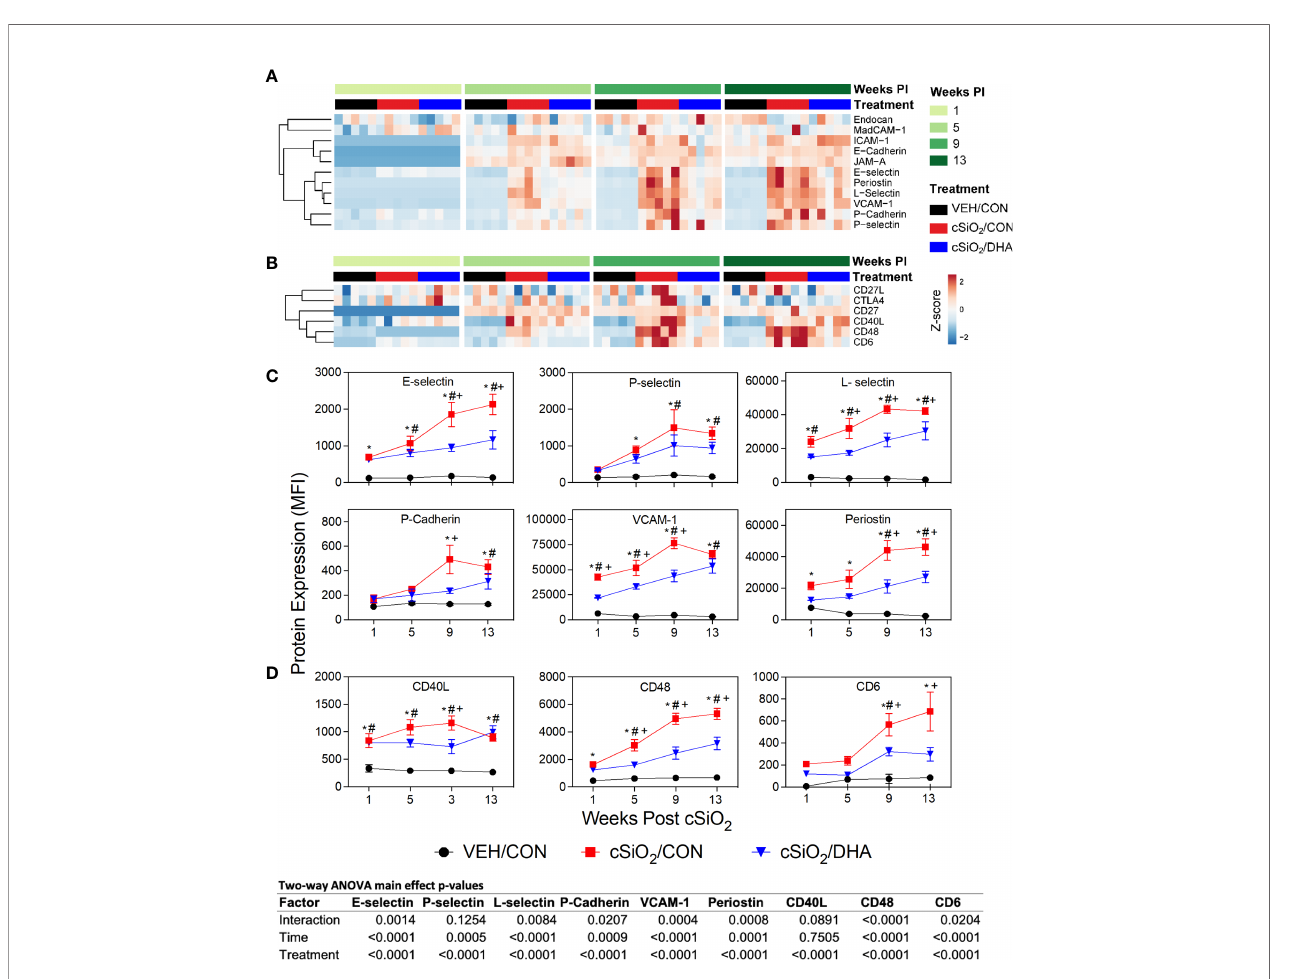
FIGURE 5 | DHA consumption suppresses cSiO 2 -induced adhesion and co-stimulatory molecule release into the BALF. Heat maps with unsupervised clustering (Euclidian distance method) depict unit variance-scaled mean fl uorescent intensities (MFIs) for (A) adhesion and (B) co-stimulatory molecules expression measured in the BALF. Black, red and blue bars above the heat map indicates the VEH/CON, cSiO 2 /CON, and cSiO 2 /DHA groups, respectively, at 1, 5, 9, or 13 wk PI. Scale bar values re fl ect the range of variance-stabilized MFIs, which were centered across rows. (C, D) Effects of DHA induction of selected (C) adhesion and (D) co-stimulatory molecules by cSiO 2 in BALF over time. MFIs were obtained using the microarray panel for VEH- or cSiO 2 -exposed mice fed CON or DHA diets. Data for select proteins were analyzed by two-way ANOVA for main effects of timepoint and treatment with post-hoc Tukey HSD multiple comparison tests to determine effects of treatment at each time point. Data are mean±SEM. Main effect p-values for timepoint, treatment, and the interaction of these factors are shown below the plots. Symbols indicate signi fi cant differences (p ≤ 0.05) as follows: * for cSiO 2 /CON vs. VEH/CON; # for cSiO 2 /DHA vs. VEH/CON; and + for cSiO 2 /CON vs. cSiO 2